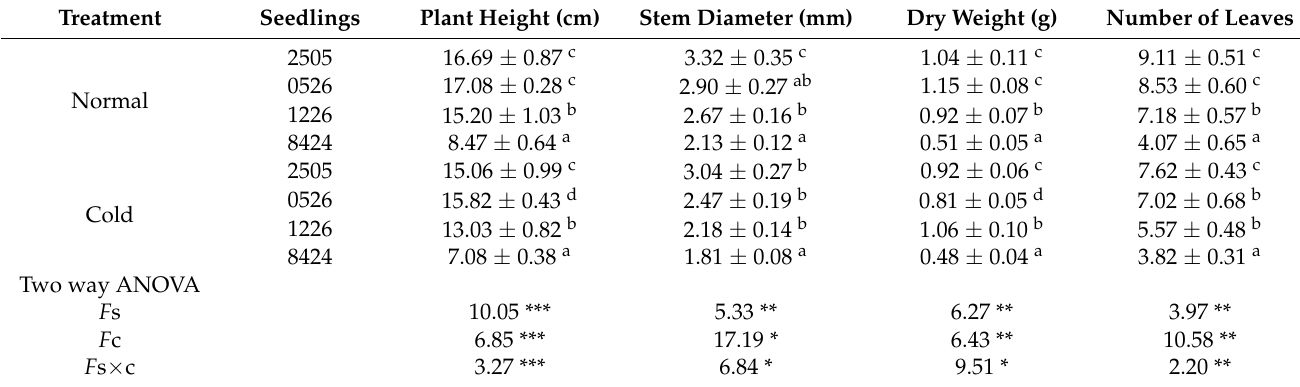
Table 2. Effects of graft combinations and cold stress on watermelon